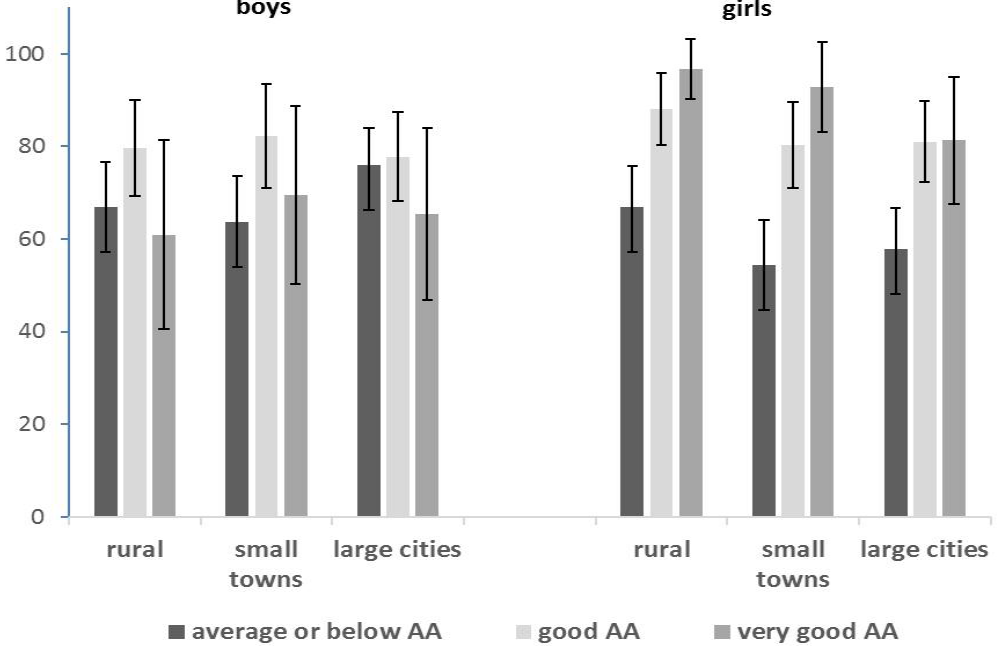
Figure 1. Non-users cluster (% with 95% confidence interval) by gender, perceived academic achievement (AA) and residence location.